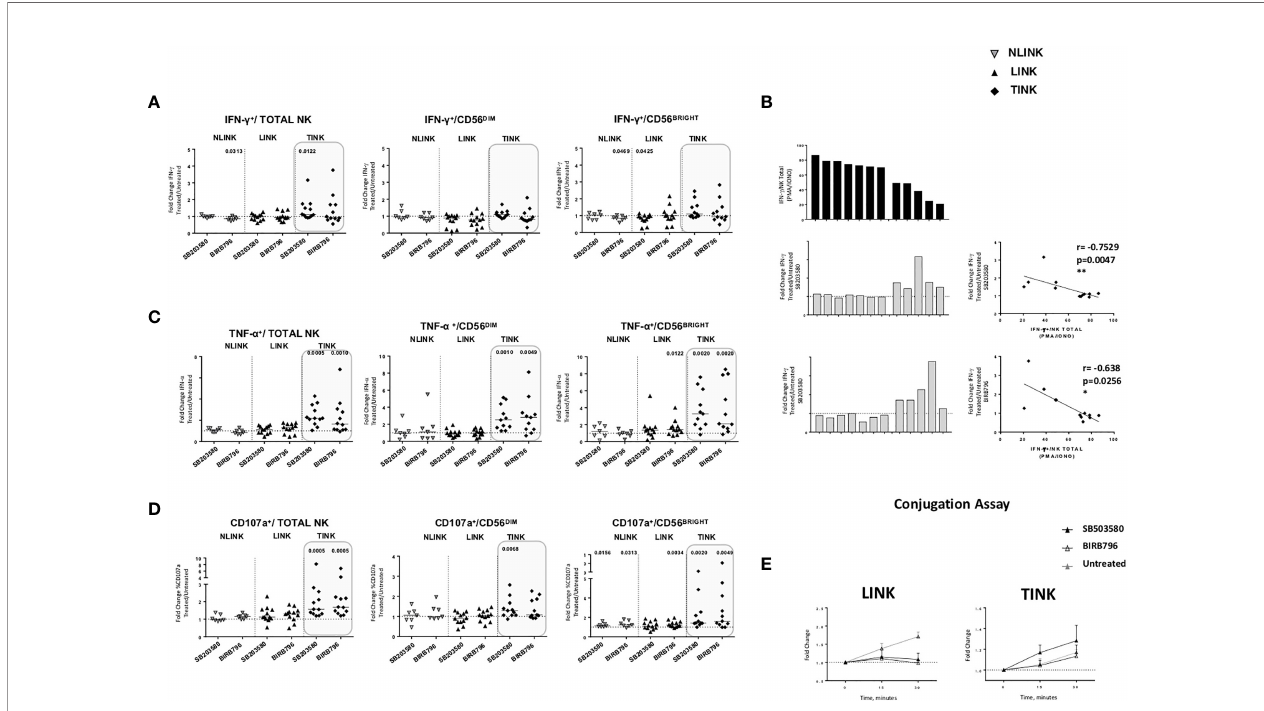
FIGURE 6 | Restoration assays of hepatocellular carcinoma-in fi ltrating NK cells. IL-12 + IL-18 O/n stimulation of NK cell stimulation with or without speci fi c p38 inhibitors was followed by fl ow cytometry determination of IFN- g (A) , TNF- a (B) and CD107a (C) production in study groups and in all NK cell subsets (total, CD56 DIM , and CD56 BRIGHT ). Data are presented as the ratio between the frequency of cytokine and CD107a-positive NK cells tested in the presence of inhibitor or untreated cultures (fold change). Horizontal lines represent median values. (D) Bar graph showing IFN- g production upon PMA/ionomycin stimulation from single TINK samples (upper panel). On the middle and lower panels, corresponding fold change values in the two p38 inhibitor-treated TINK samples. Right panels: correlation between IFN- g production and response to p38 blockade. (E) Conjugation assay performed on LINK and TINK samples with or without p38 inhibition. (A – C) Statistical analysis by Wilcoxon signed-rank tests. (D) Statistics by Pearson ’ s correlation. (A – E) LINK ( n = 11) and TINK ( n = 11). *p < 0.05, **p <